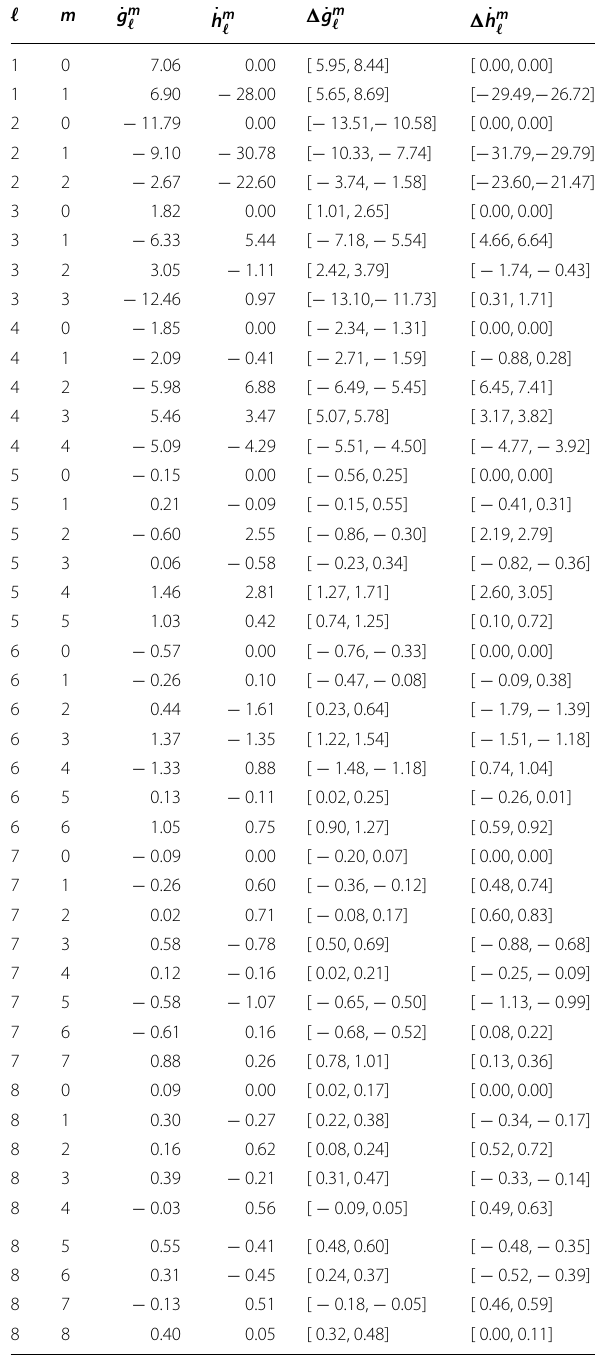
Table 3 The submitted candidate model with our estimate of its uncertainties (90% confidence